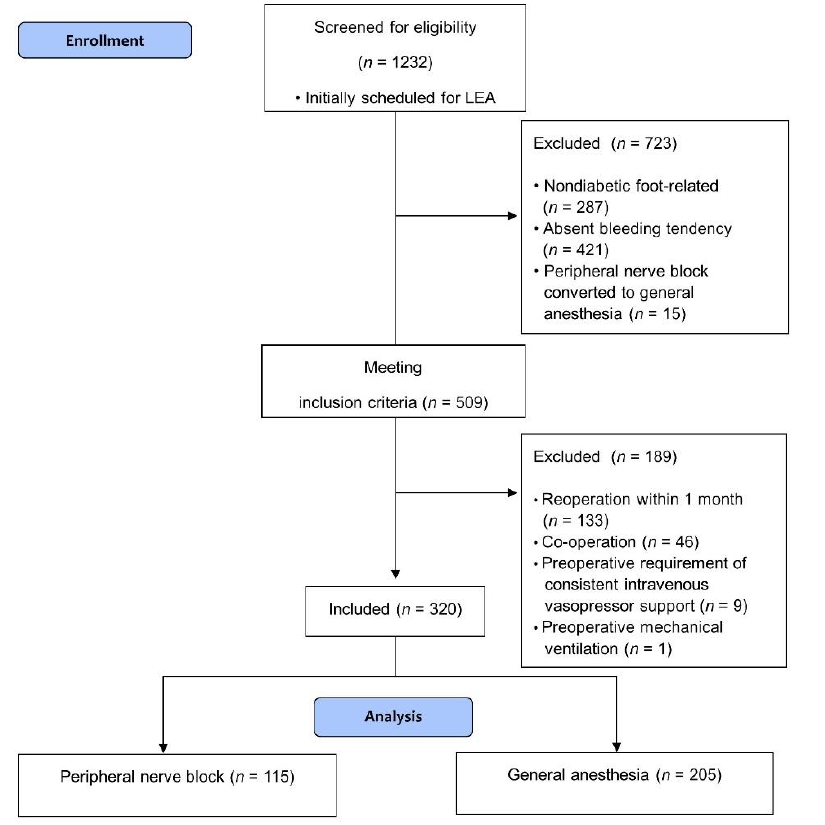
Figure 1. Flow chart of patient enrollment. Table 1. Baseline patient characteristics before and after IPTW adjustment.